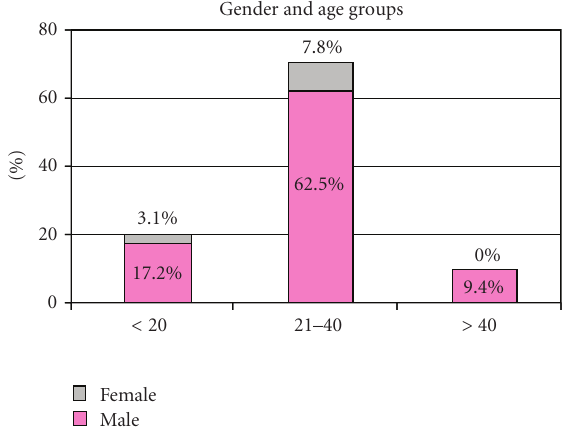
Figure 1: Age distribution of patients with penetrating bladder injury.